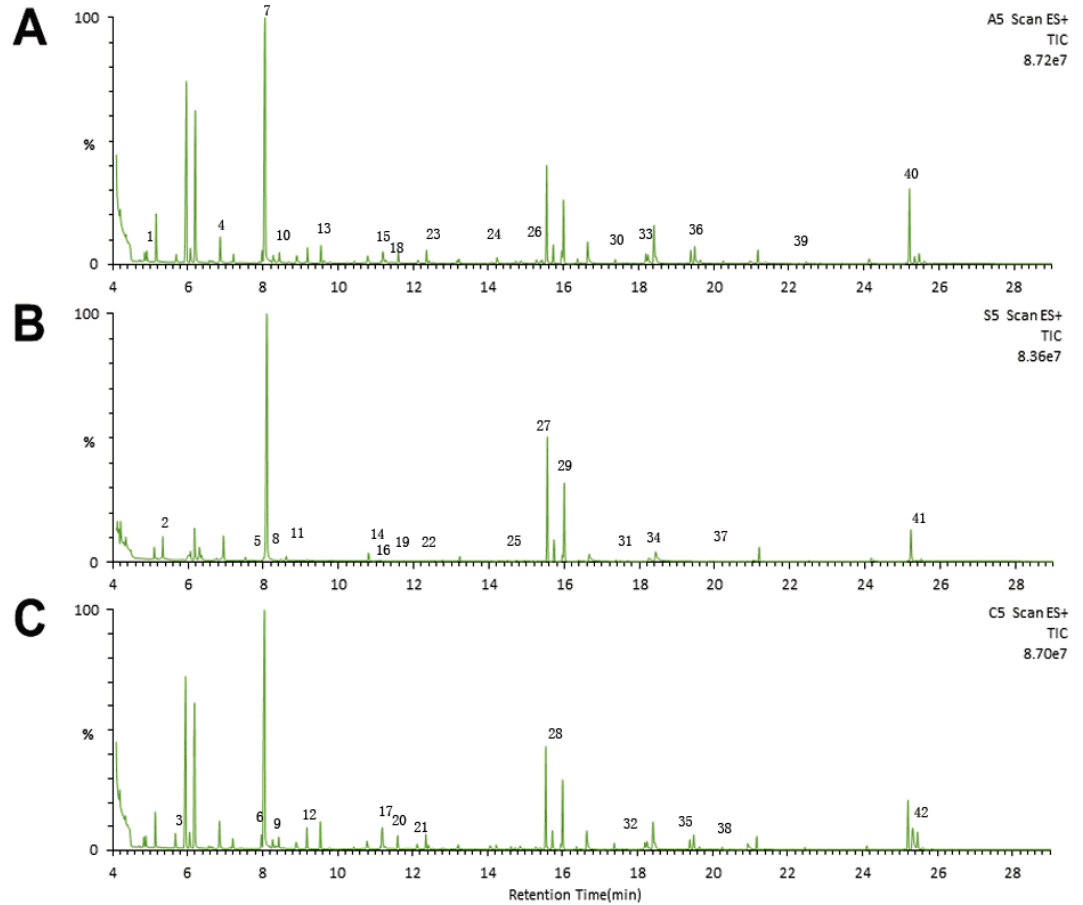
Figure 2. Representative gas chromatography–mass spectrometry (GC–MS) total ion chromatograms. Chromatograms from the ( A ) Hu-H1 group; ( B ) Strain V group;